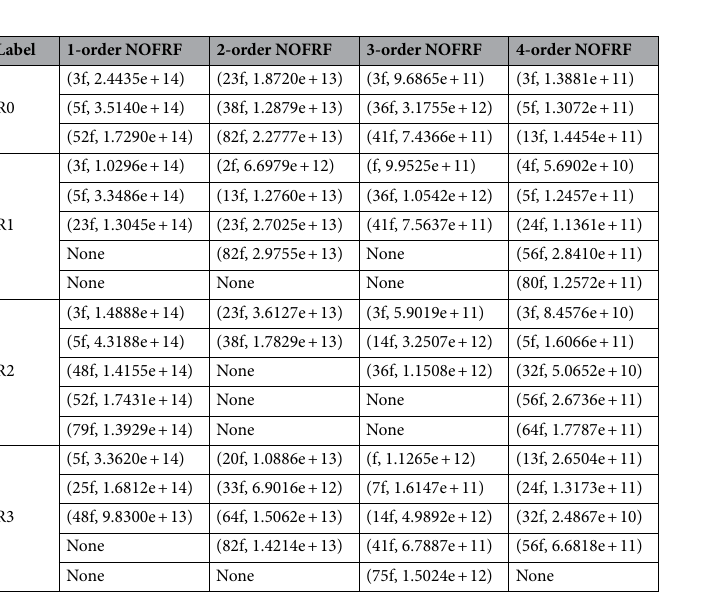
Table 2. The key characteristics frequency points distribution of NOFRF spectrum in different states (basic frequency f = 0.3